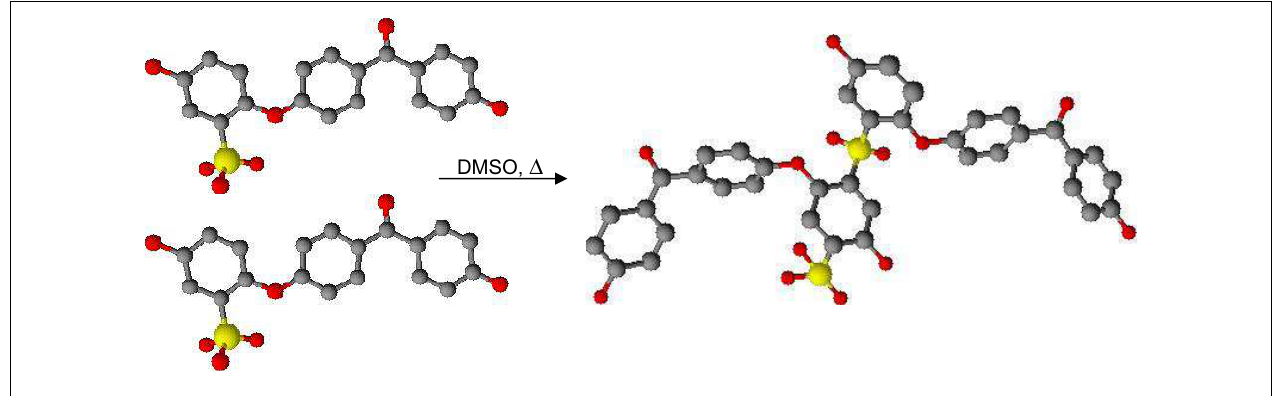
FIGURE 1 | Cross-link reaction for SPEEK (color code: gray C, yellow S, red O) .